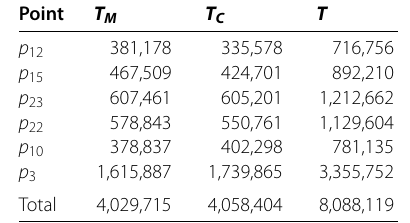
Table 3 The distribution of military T M , control T C , and total T tweets per Twitter point of interest Point T M T